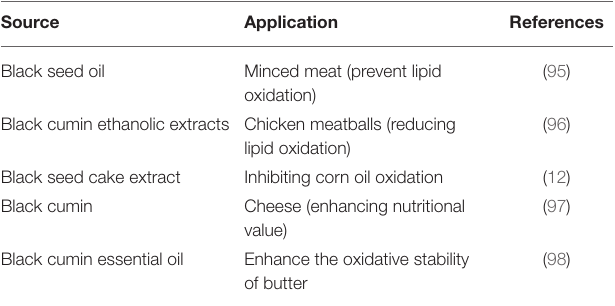
TABLE 4 | Application of bioactive compounds obtained from black seed and its by-products in the food industry.